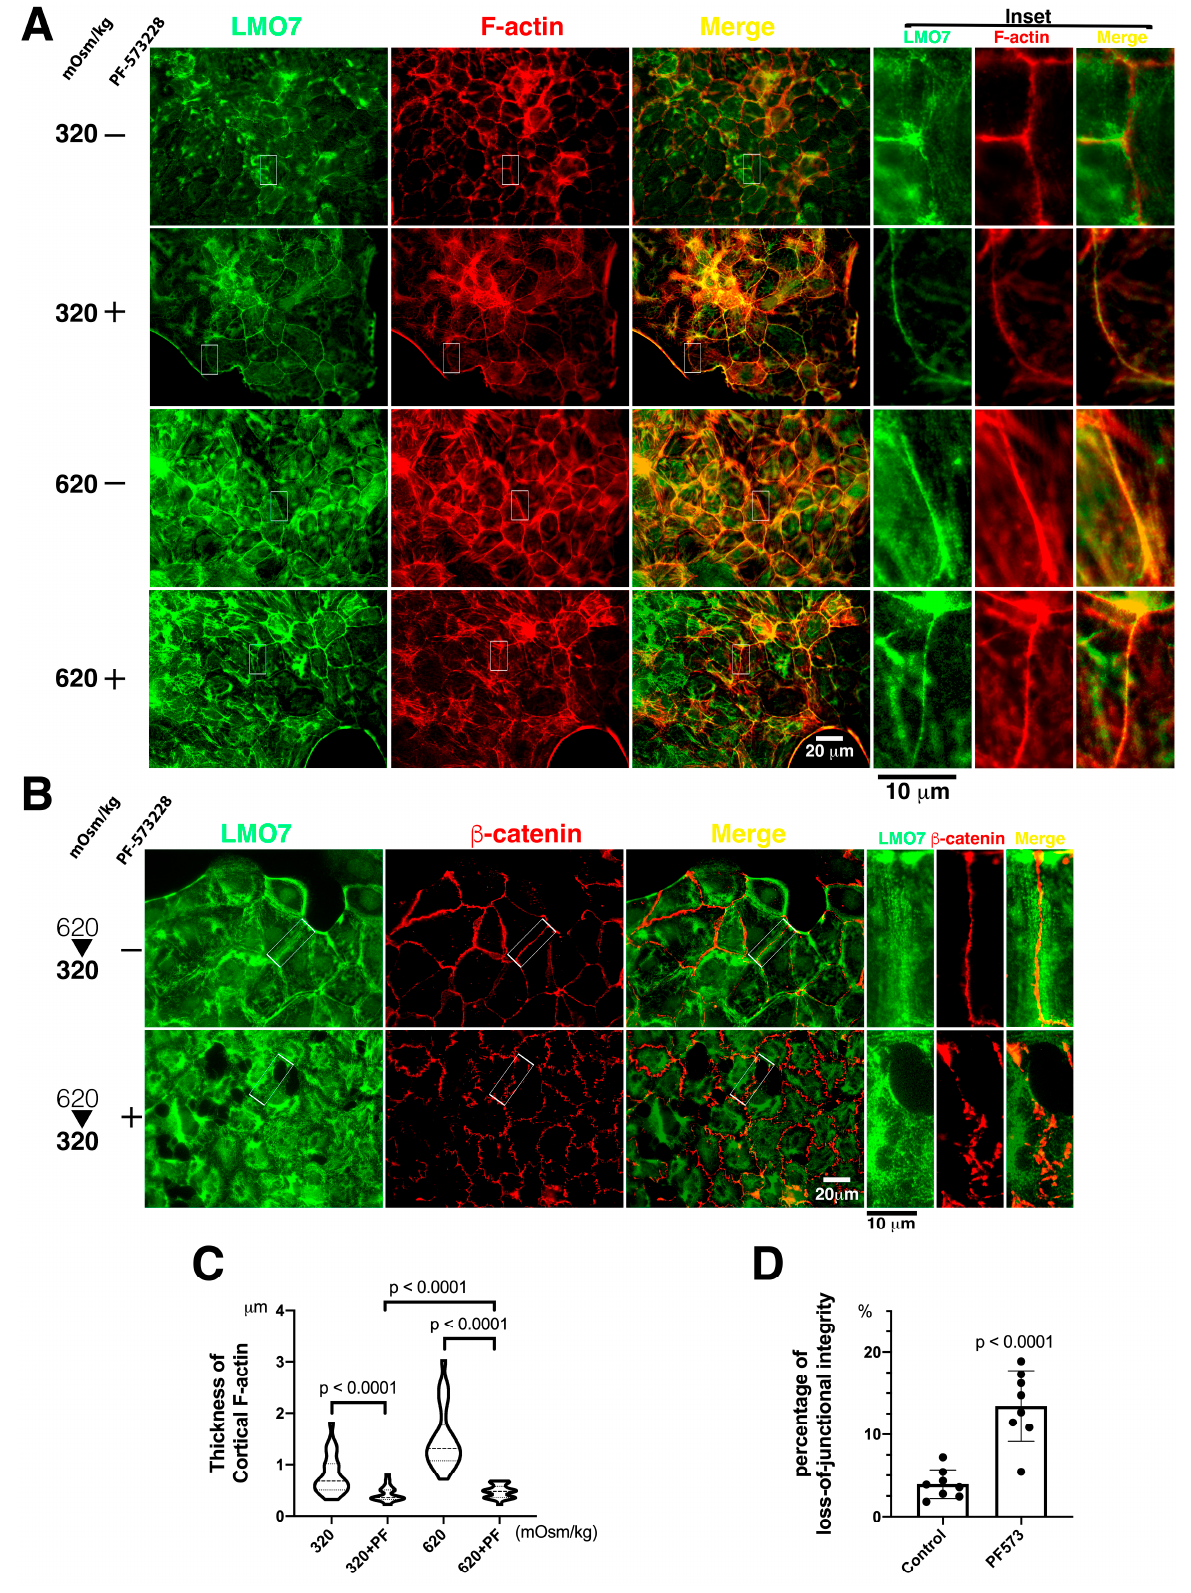
Figure 5. Fine peripheral stress fibers, less LMO7, and junctional integrity loss are present in FAK inhibitor-administrated cells in epithelial sheet. ( A ). The enzymatic function of focal adhesion kinase is blocked by PF-573228. The LMO7 (Green) in NRK-52E cells in epithelial sheet-like cells is